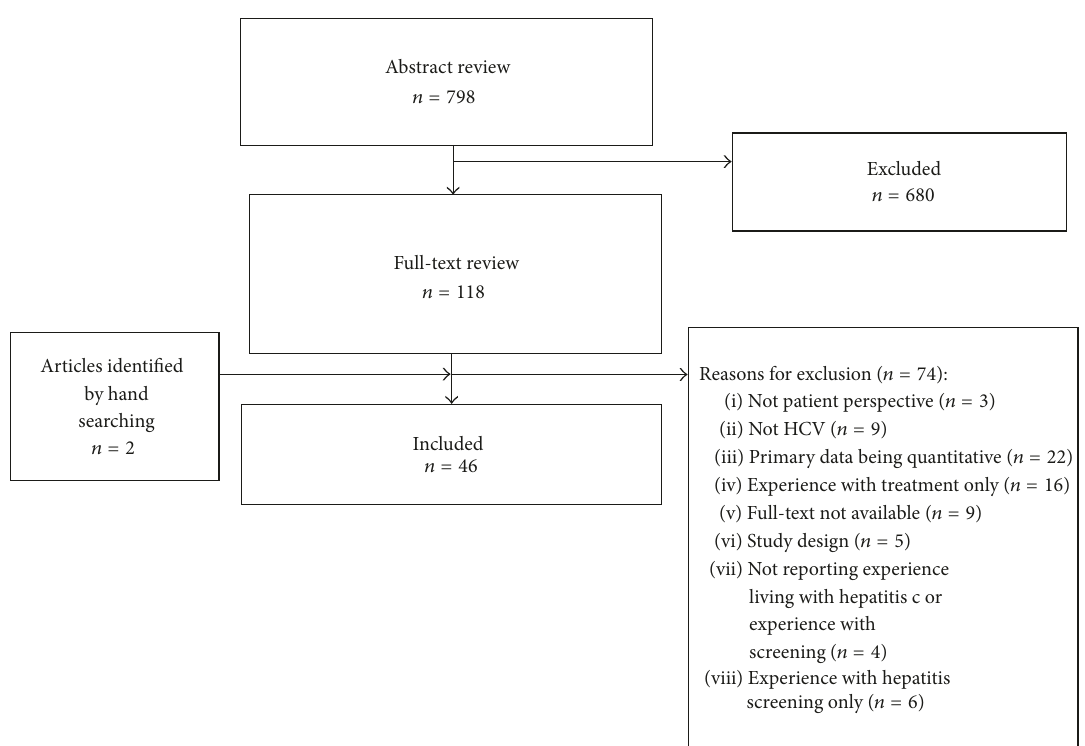
Figure 1: Flow chart of included and excluded